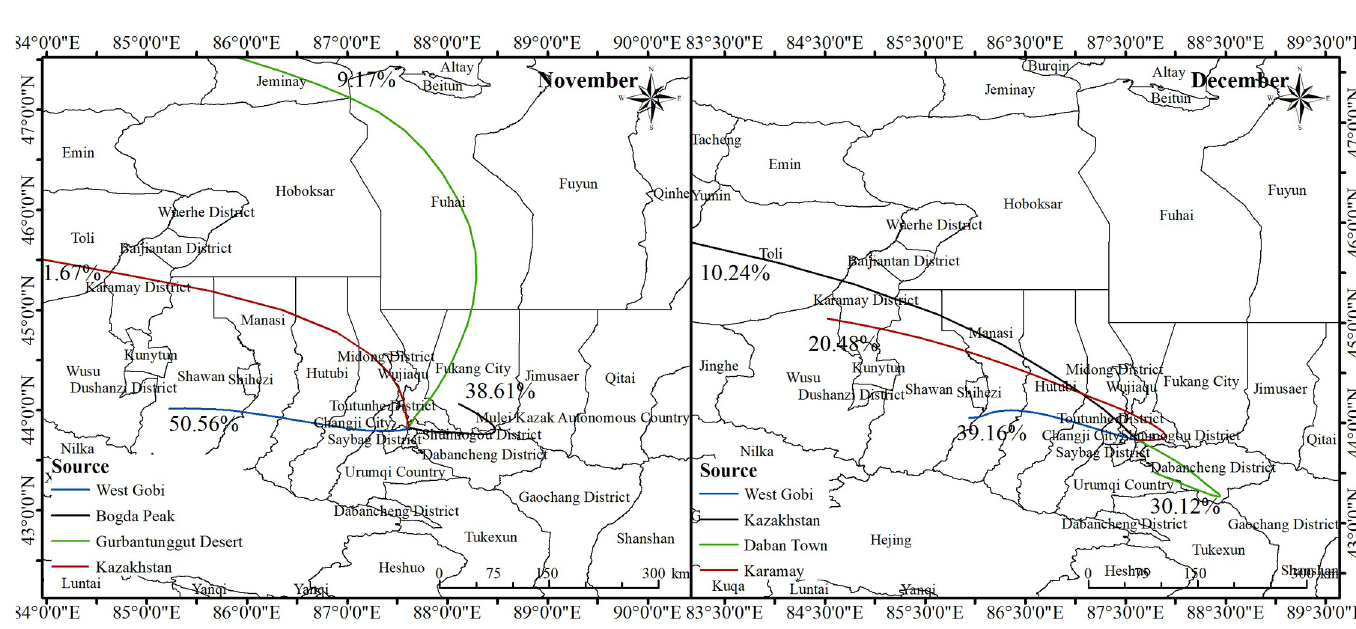
Fig 10. Backward trajectory cluster distribution.